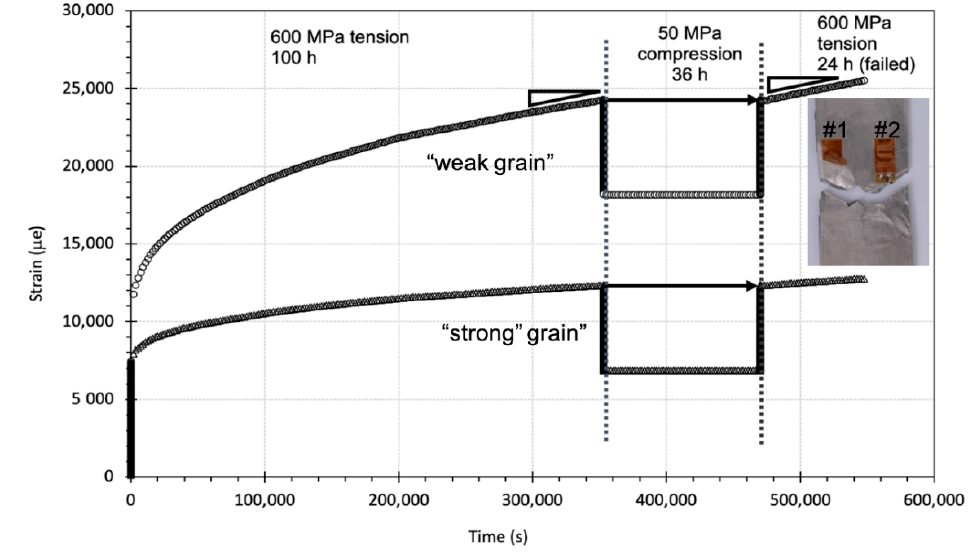
Figure 7. Strain accumulation over time within two individual grains.